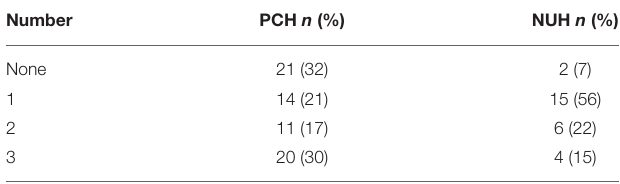
TABLE 3 | Number of additional non-TBI injuries.